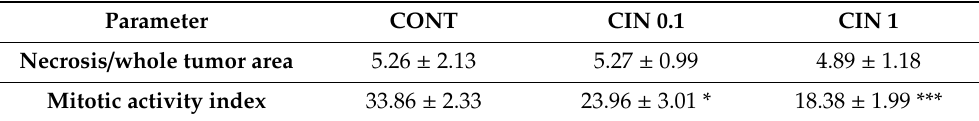
Figure 2. Tumor volume of mouse 4T1 mammary adenocarcinomas during the experiment. Data are Table 3. Histopathological characteristics of 4T1 tumors in Balb / c mice after C. zeylanicum treatment. Table 3. Histopathological characteristics of 4T1 tumors in Balb/c mice after C. zeylanicum treatment.